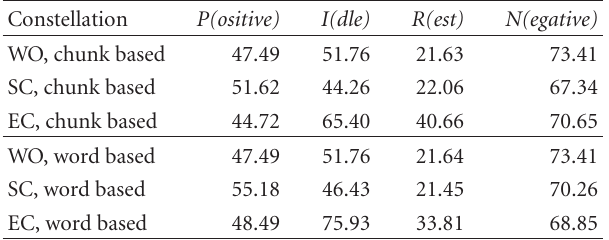
Table 10: Classwise recall values (i.e., diagonal values of confusion matrices), acoustics + linguistics; chunk evaluation in percent correct. Note that the chunk- and the word-based evaluations of WO